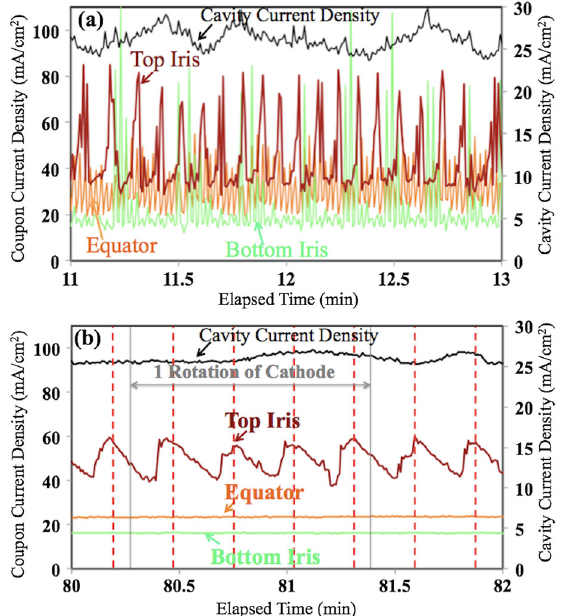
FIG. 5. Coupon and cavity current densities obtained with (a) rod cathode and (b) NC-1. The red dotted vertical lines in (b) show the times when the blades faced the top iris coupon. The grey solid vertical lines in (b) represent the logged signal of cathode rotation.